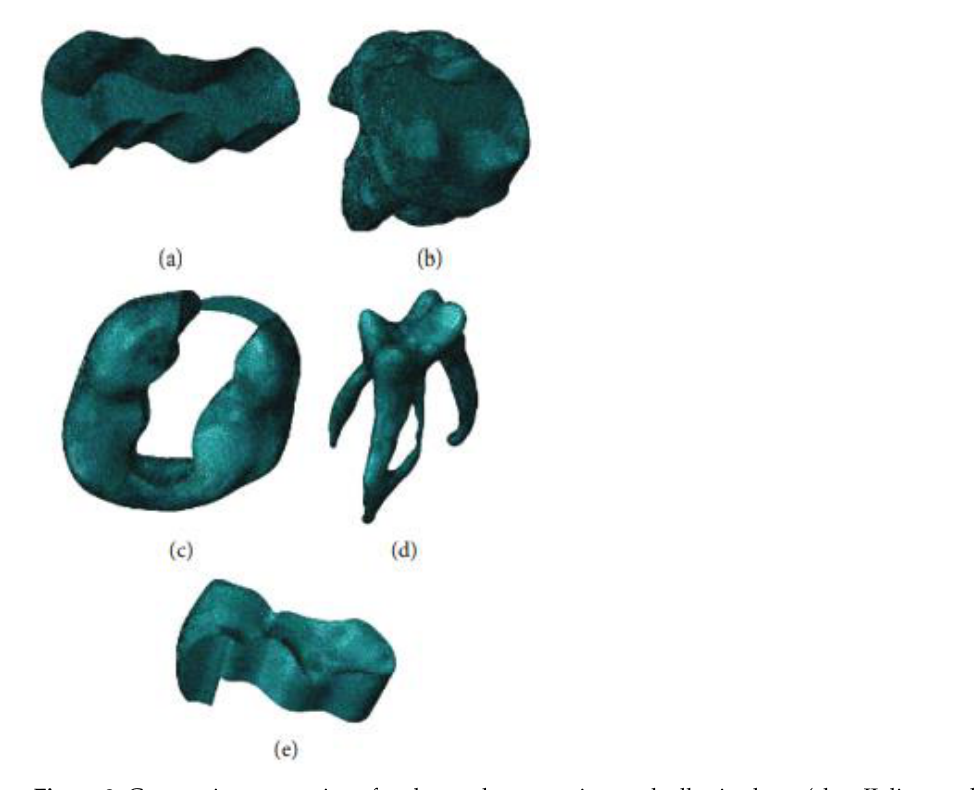
Figure 3. Geometric construction of molar tooth, restoration, and adhesive layer (class II disto-occlusal cavity: ( a ) adhesive layer, ( b ) dentine, ( c ) enamel, ( d ) pulp, ( e ) restoration).